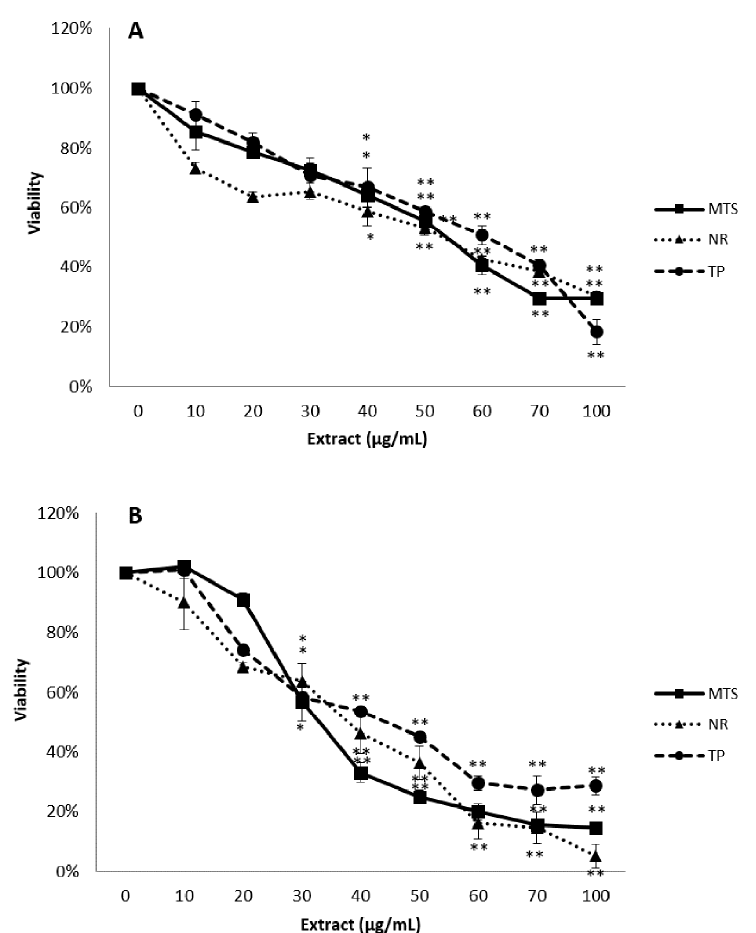
Figure 2. Reduction of tetrazolium salt (MTS), neutral rep uptake (NR), and total protein content (TP) of Caco-2 cells exposed for 24 h ( A ) and 48 h ( B ) to 0–100 μ g/mL of the stilbene extract (45%). All values expressed as mean ± SD. Significant differences in respect to the control from p < 0.05 (*) and p < 0.01 (**).